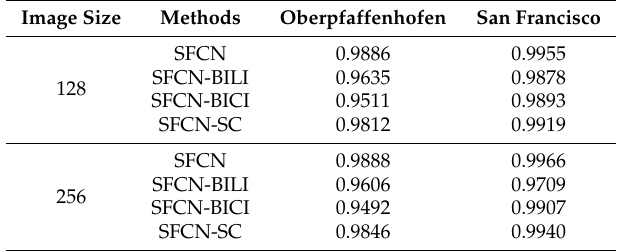
Table 6. Classification results of Oberpfaffenhofen and San Francisco with different methods.